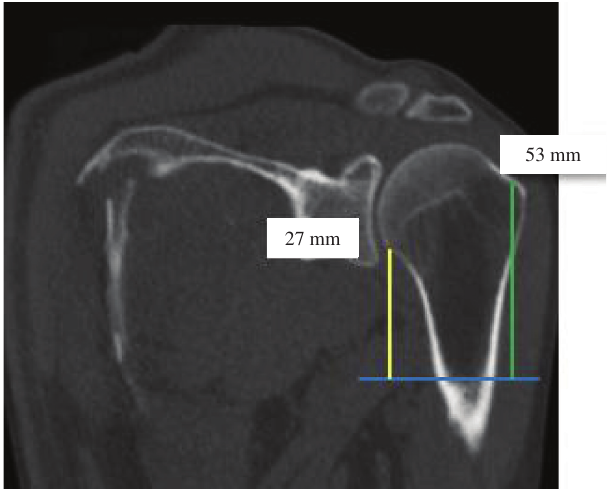
Figure 13. PM-humeral head distance (green) was almost two times greater than PM-change of curvature distance (yellow) (ratio = 0.4).